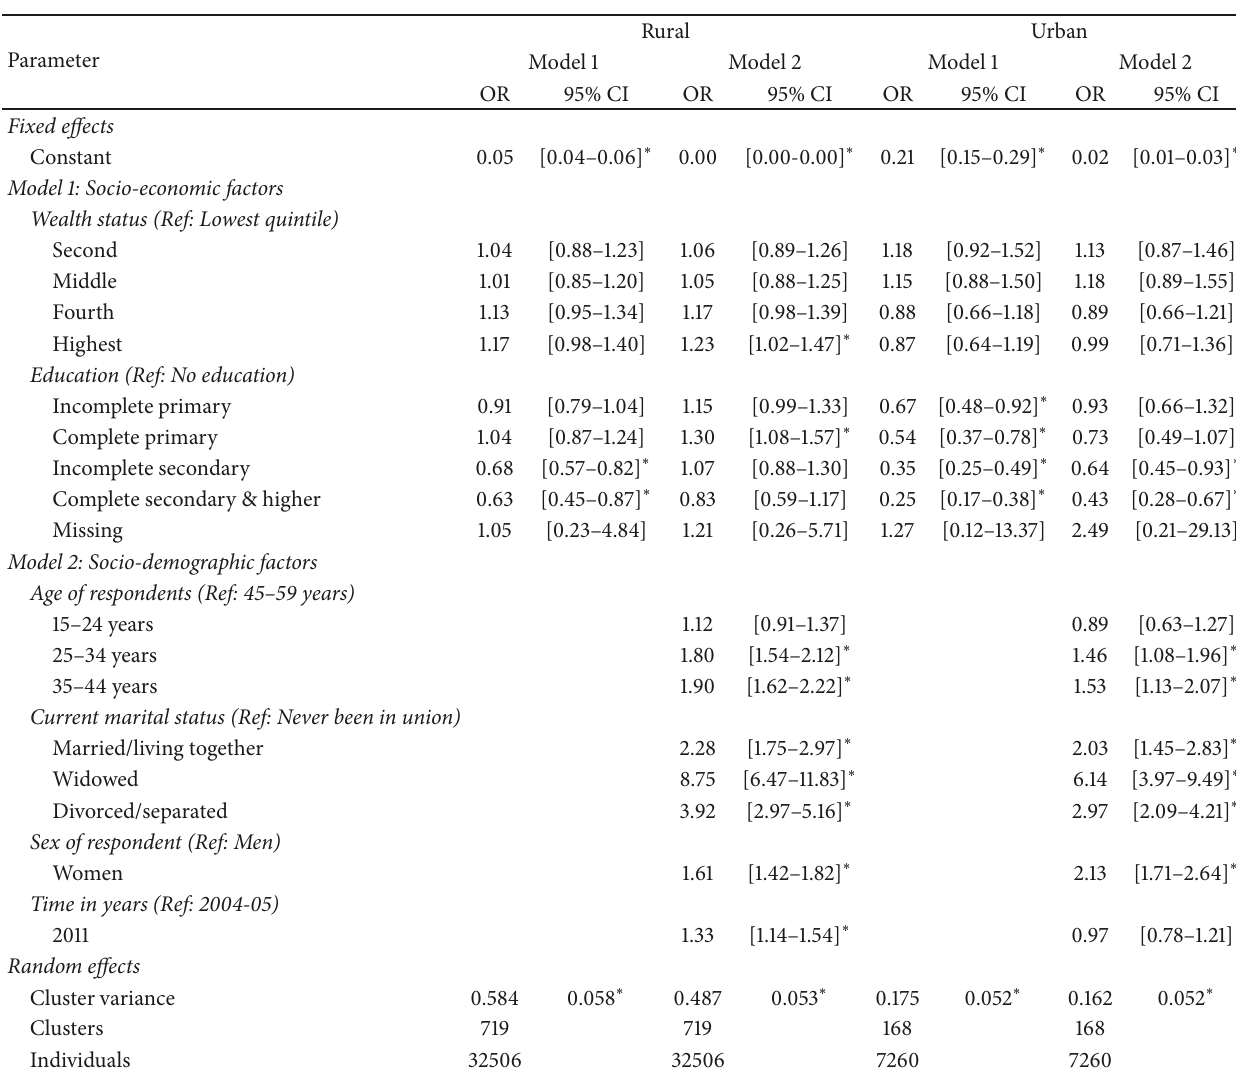
Table 4: Odds ratios (OR) of HIV prevalence in rural and urban areas, UAIS, 2004-2005 and